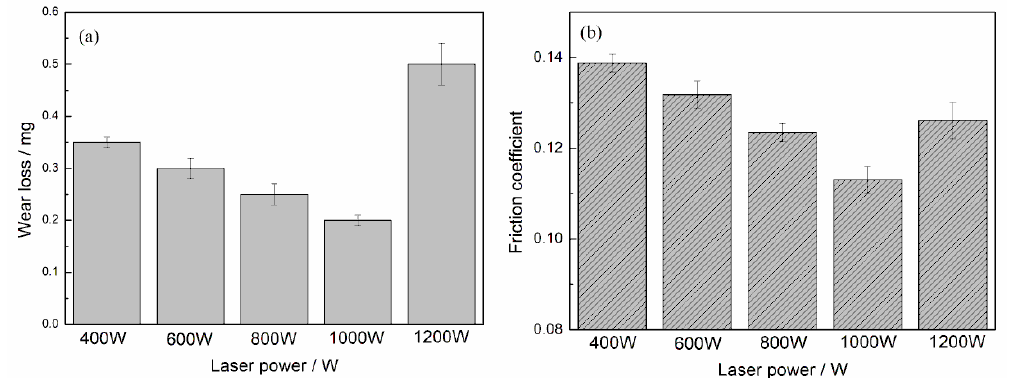
Figure 13. Effect of laser power on the ( a ) wear loss and ( b ) friction coefficient.